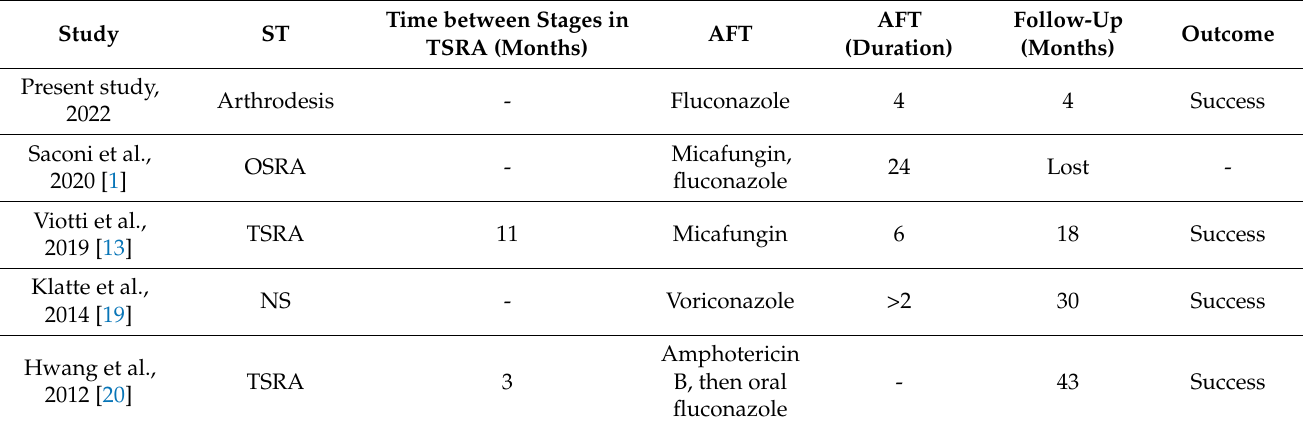
Table 2. Management of reported PJI cases due to Candida lusitaniae